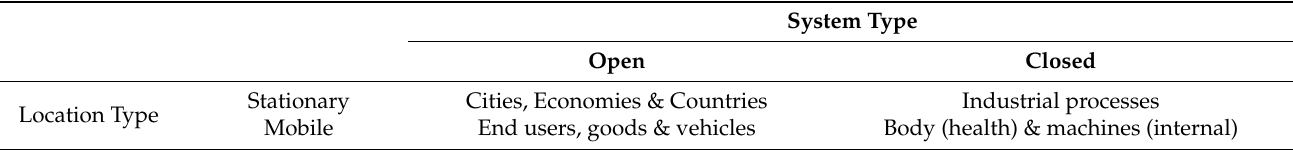
Table 1. Taxonomy of Digital Twin Context